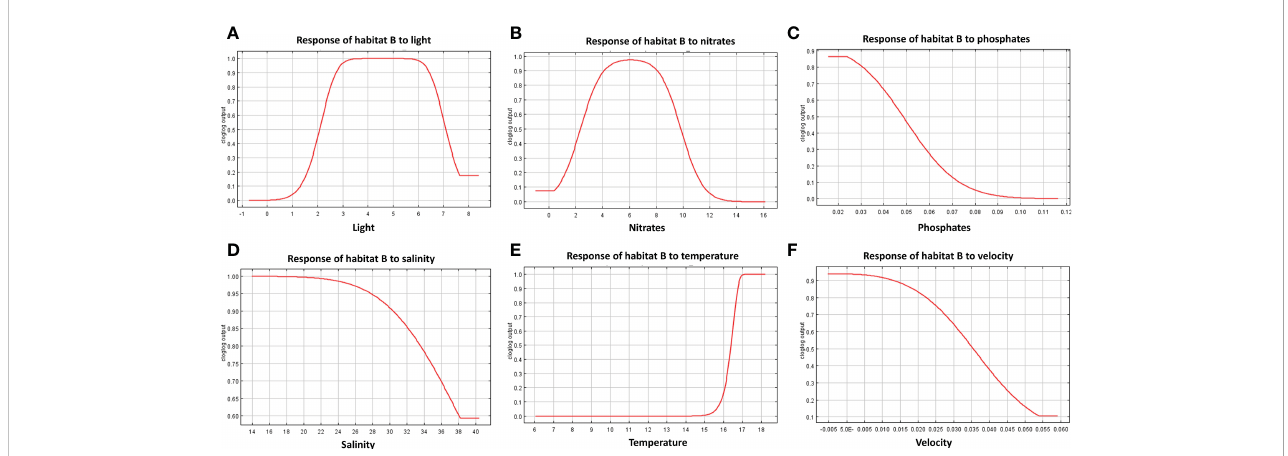
FIGURE 8 Response curves derived from MaxEnt reporting the relationship of predicted suitability of habitat B to environmental variables, with y-axis indicating the probability values and x-axis the concentration/intensity of the variables: (A) relationship between habitat B and light; (B) relationship between habitat B and nitrate concentration; (C) relationship between habitat B and phosphate; (D) relationship between habitat B and salinity; (E) relationship between habitat B and temperature; (F) relationship between habitat B and